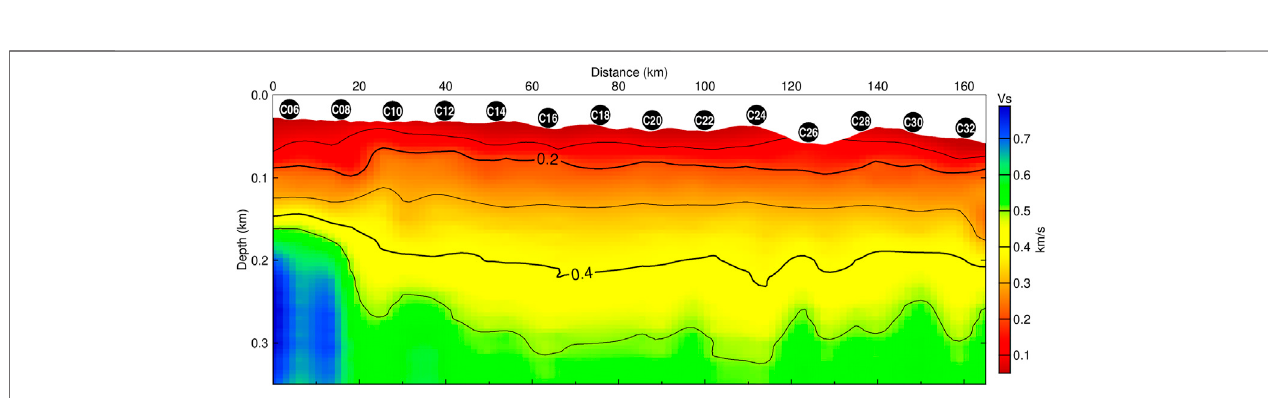
FIGURE 11 | Final 2D shear-wave velocity structure of the survey pro fi le. C06 – C32 denote the deployed OBS positions.